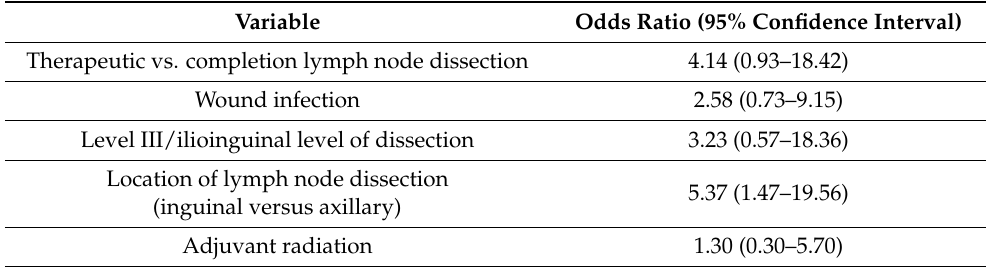
Table 4. Multivariate analysis of the rate of lymphedema compared with predictive factors.